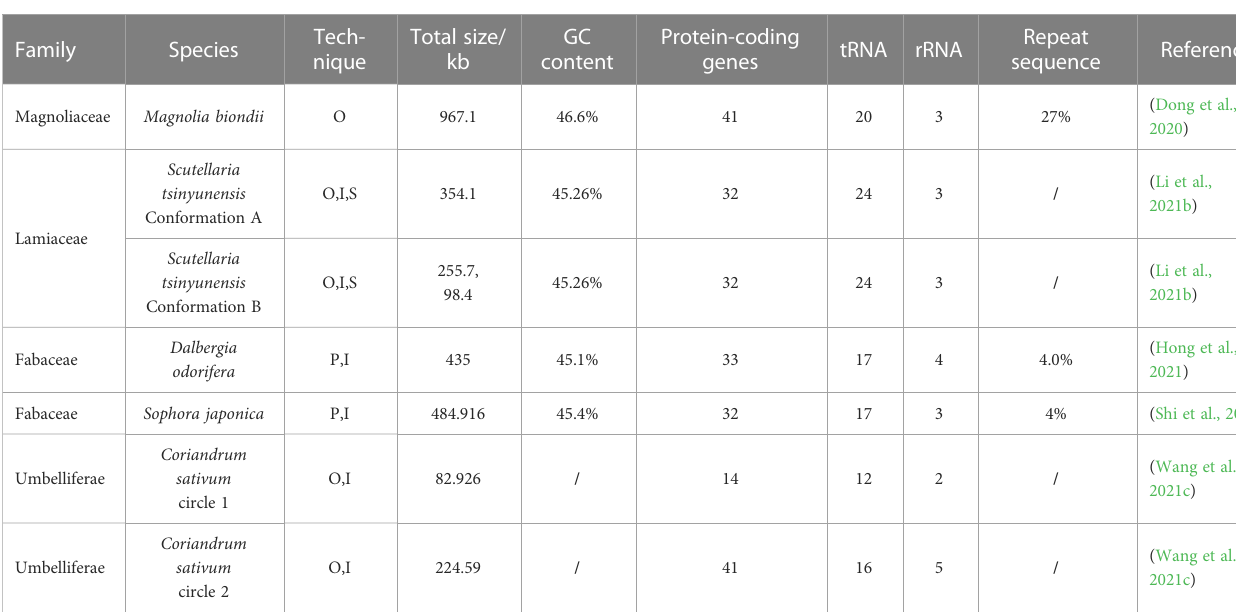
TABLE 3 Mitochondrial genome assemblies obtained using TGS